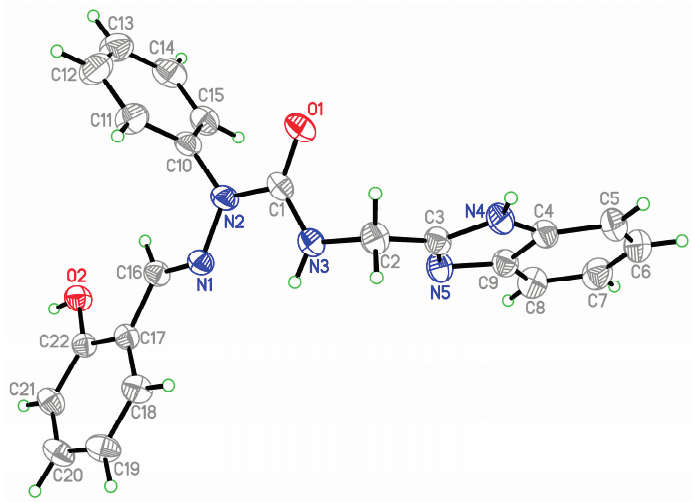
Figure 5. ORTEP drawing of salicylaldehyde 2-phenyl-4-[(1 H -benzo[ d ]imidazol-2- yl)methyl]semicarbazone ( 12a